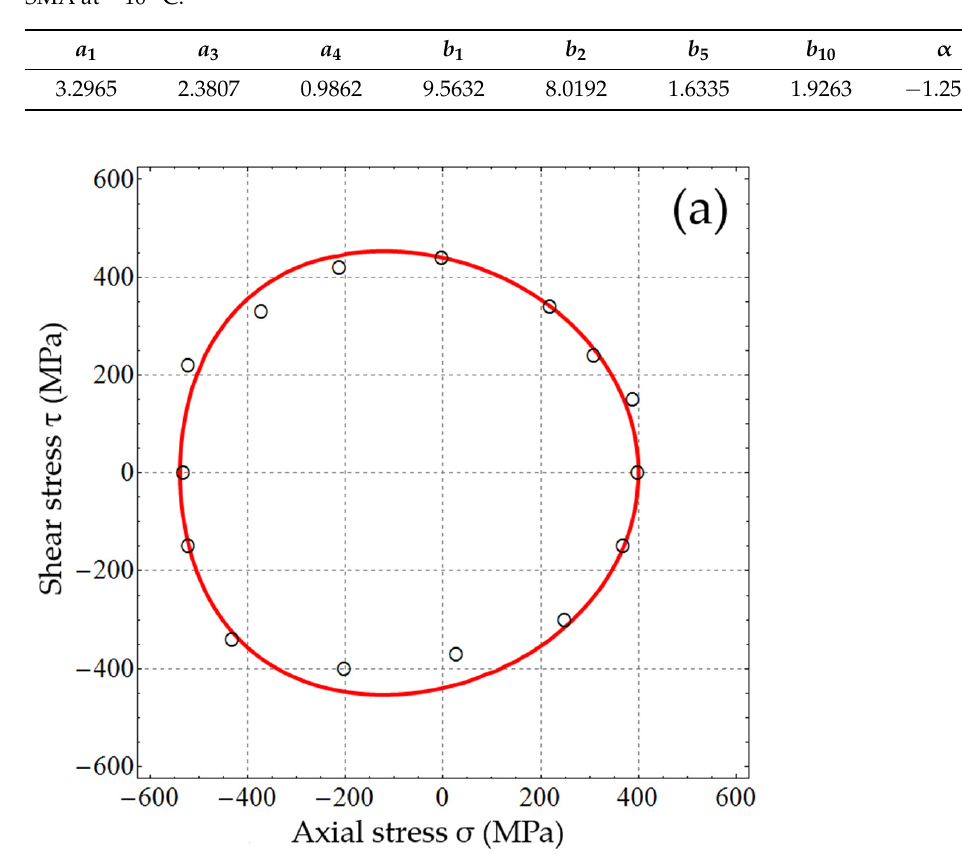
- J 0 criterion for Ni–Ti 2 3